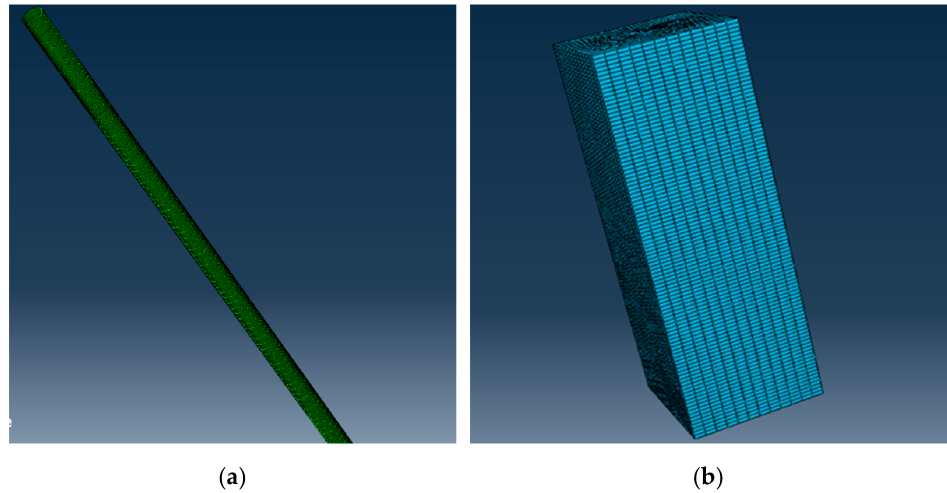
Figure 7. Meshing of finite element models. ( a ) Pipe pile model. ( b ) Soil model.